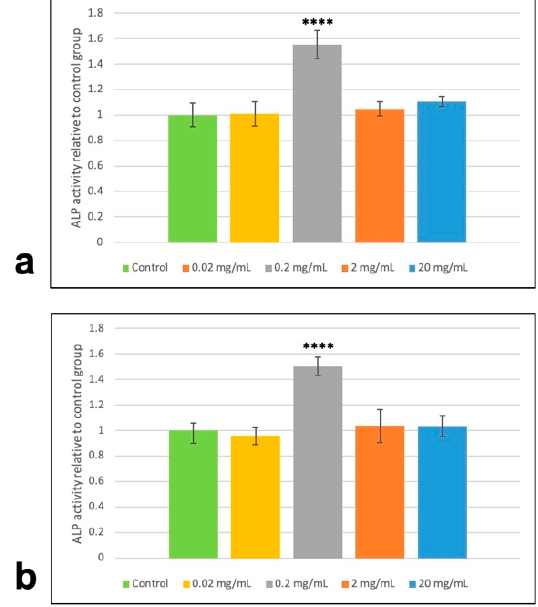
Figure 3. Investigating the effects of MTA-conditioned media on alkaline phosphatase activity (ALP) of human MSCs. ALP activity of ( a ) BM-MSCs and ( b ) Ad-MSCs following treatment with different concentrations of MTA-conditioned media after 14 days. Human MSCs incubated in 0.2 mg/mL MTA-conditioned media had significantly higher ALP activity compared to the control and other treated groups. Values are mean ± SD, n = 3, **** indicates p < 0.0001. After 14 days, alizarin red S staining indicated that MTA-treated MSCs presented a notable increase in the number of mineralized nodules compared with control groups (Figure 4).